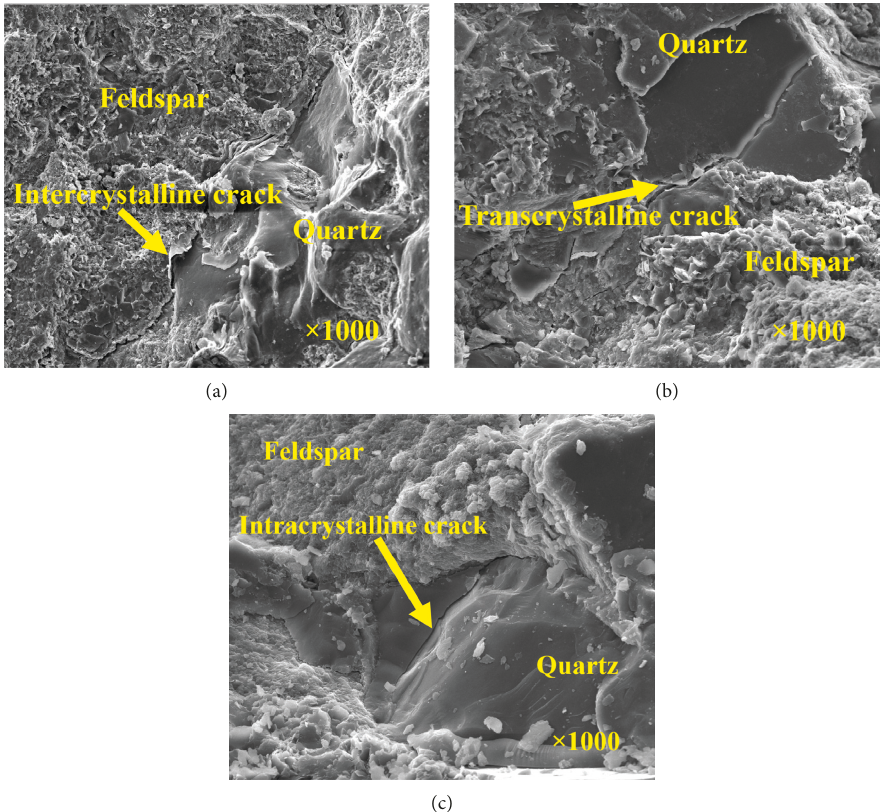
Figure 8: Three typical microcracks: (a) intercrystalline crack, (b) transcrystalline crack, and (c) intracrystalline